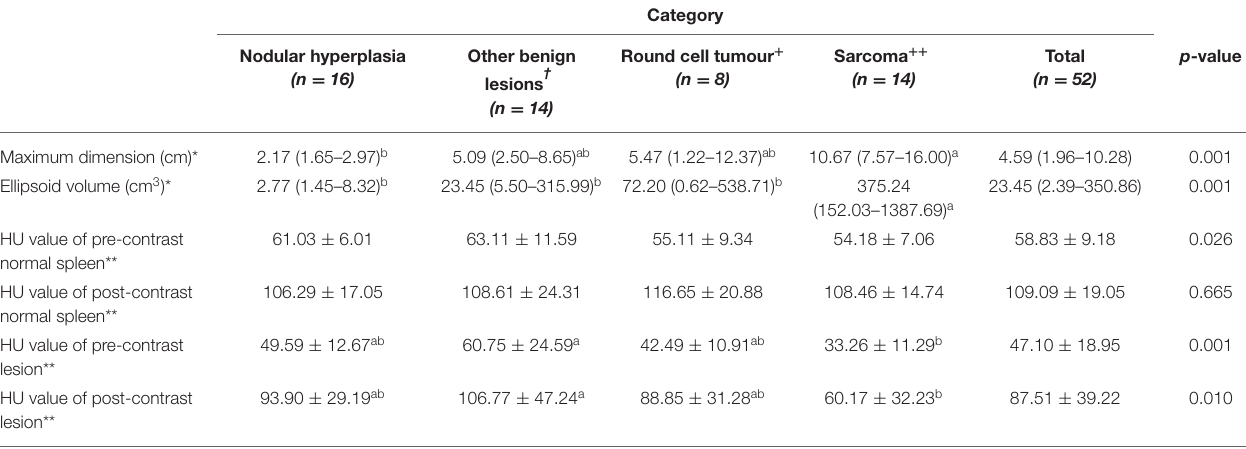
TABLE 2 | Quantitative features, along with cytological or histological